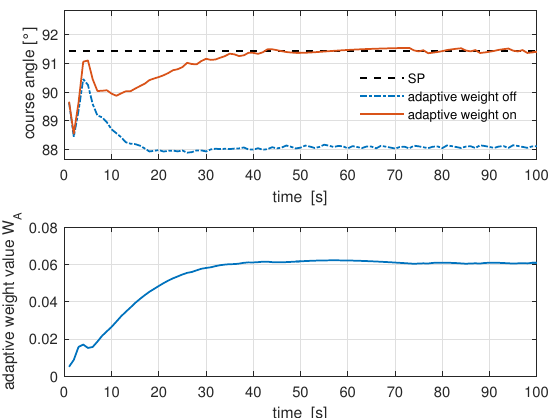
Figure 14. Course tracking data with and without adaptive weight term. The top graph shows the change of heading during the course of navigation. The SP (Set Point) is heading control input. The solid orange line shows the change of heading with adaptive weight, and the dashed blue line shows the change of heading without adaptive weight. The lower graph shows the trend of the adaptive weight value W A during the course of the